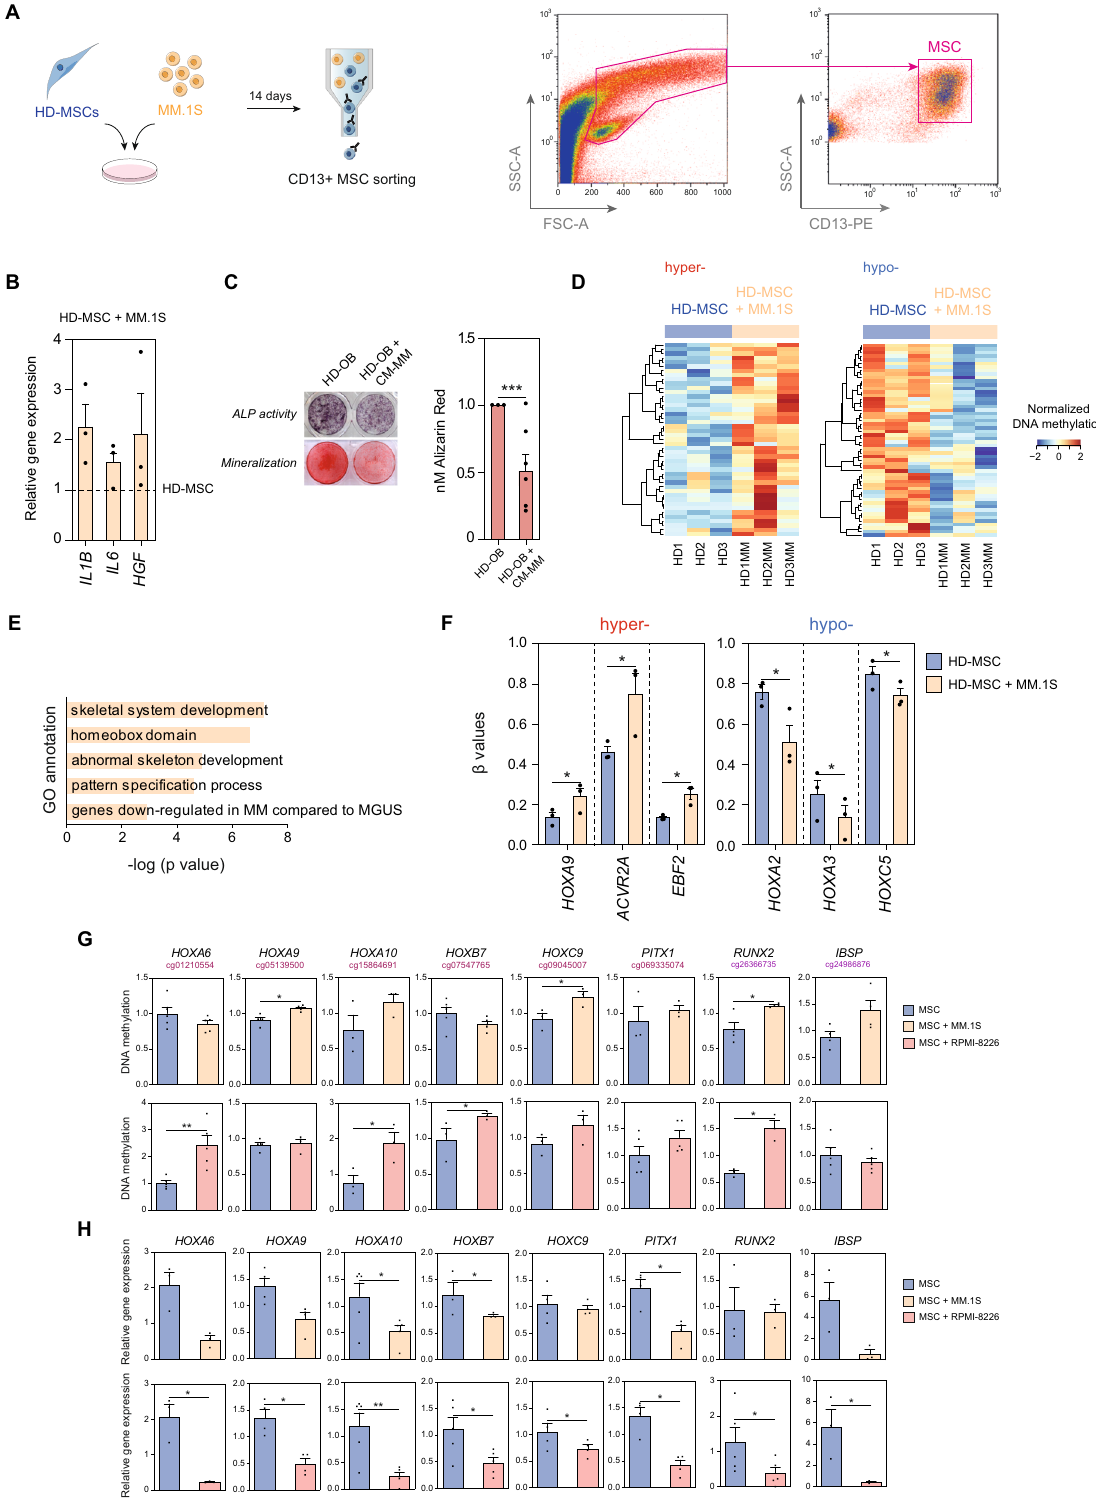
To further examine the in vivo effect of CM-272 on DNA methylation of myeloma-associated MSCs, we performed reduced representation bisul fi te sequencing (RRBS) analysis of MSCs isolated from vehicle- and CM-272-treated myeloma-bearing mice using healthy mice as controls. First, we observed signi fi cant alterations in the DNA methylome of MSCs from myeloma- bearing mice compared to healthy mice (Supplementary Data 8). NATURE COMMUNICATIONS| (2021) 12:421